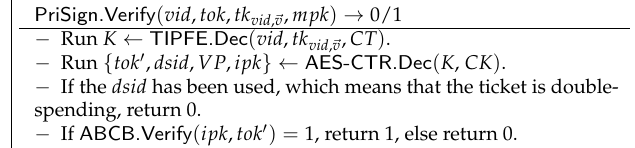
Figure 12. Verify